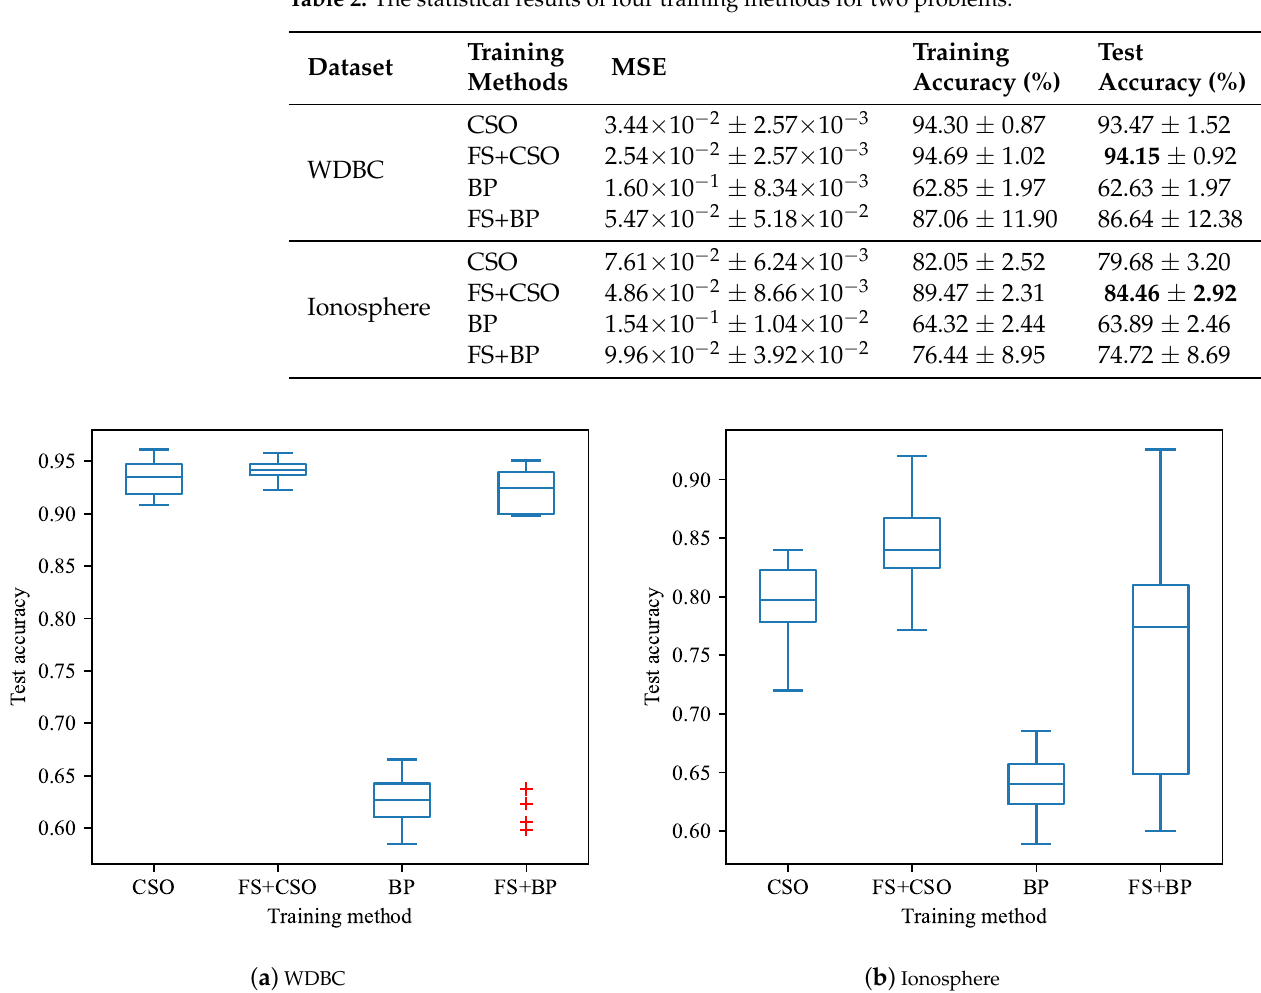
Figure 6. Box and whisker diagram of the test classification accuracy of four training methods for two